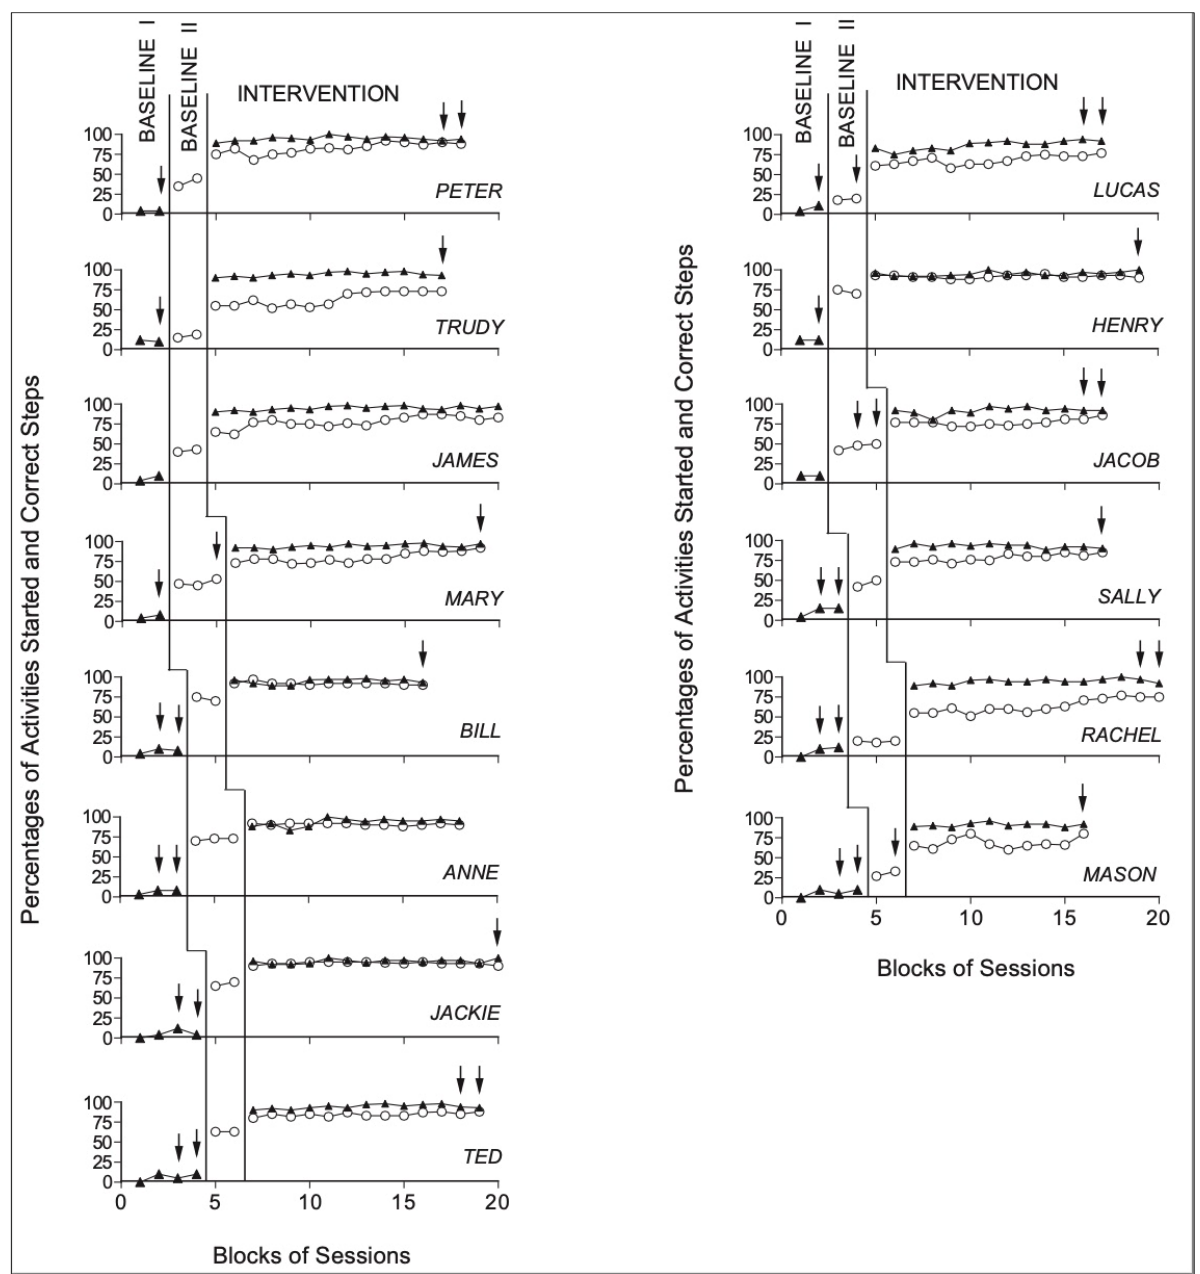
Figure 1. The eight panels to the left of the figure summarize the baseline and intervention data of the eight participants of Group 1 (i.e., Peter, Trudy, James, Mary, Bill, Anne, Jackie, and Ted). The six panels to the right of the figure summarize the baseline and intervention data of the six participants of Group 2 (i.e., Lucas, Henry, Jacob, Sally, Rachel, and Mason). The black triangles and empty circles represent mean percentages of activities started independently and of activity steps carried out correctly per day over blocks of days, respectively. The blocks include 3 days (2 days when an arrow is present).